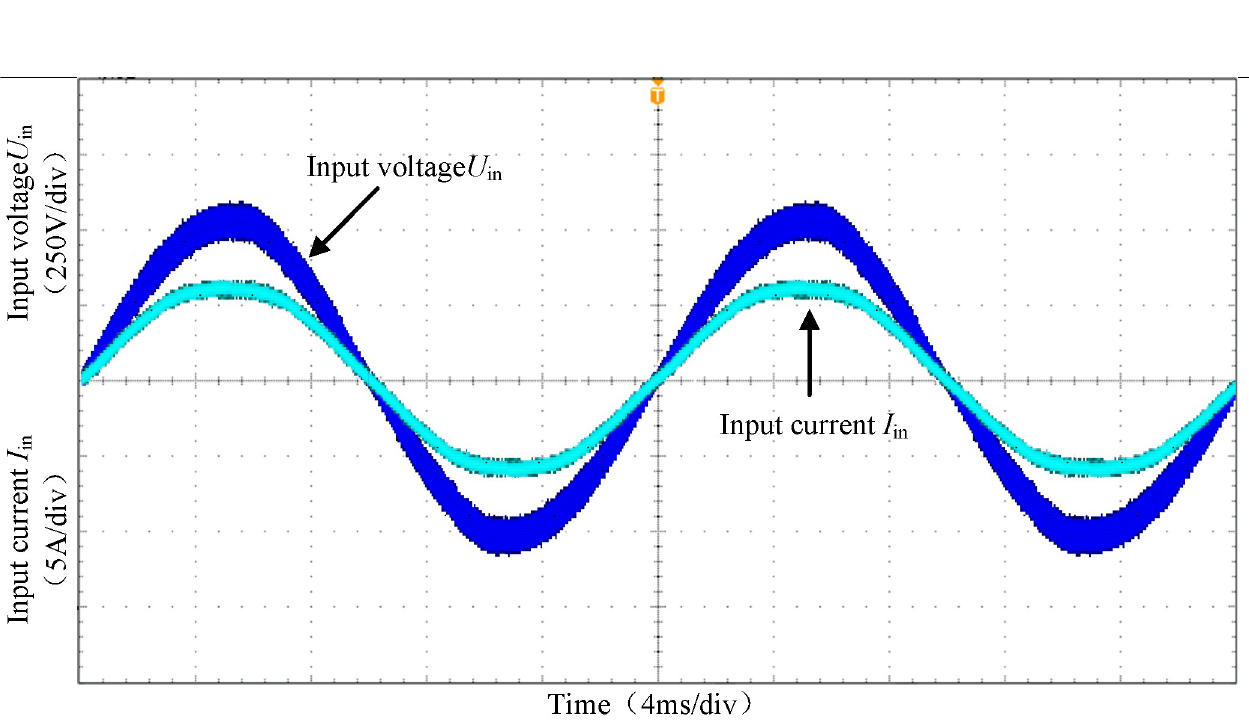
Fig 26. The input voltage and current waveforms of PFC.